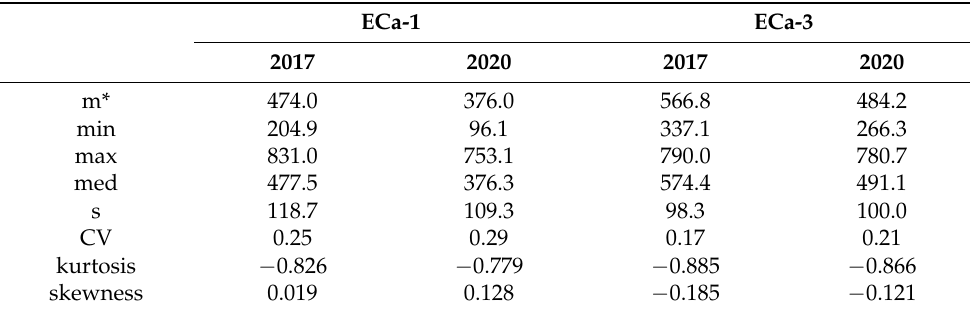
Table 2. Descriptive statistics of interpolated ECa-1 and ECa-3 (mS m − 1 ) in 2017 and